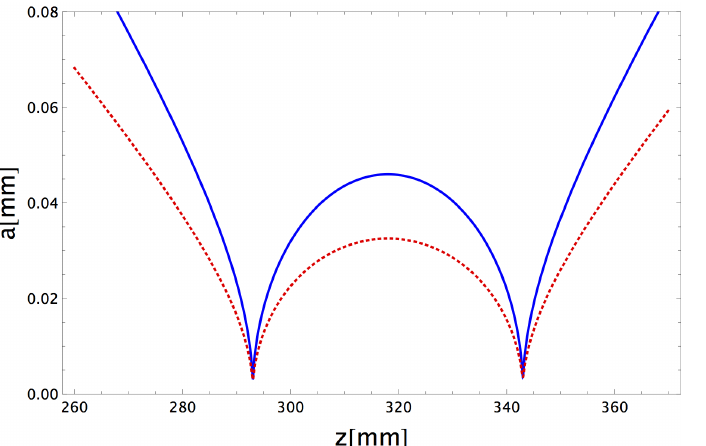
Figure 4. Behaviour of the limit object ˜ a (dashed red line) and a (cid:48) (solid blue line) as a function of the distance z between the object and the lens. The two functions have consistent behaviours, with minima close to the two reference planes z a = 293mm and z b = 343mm and a local maximum close to the midpoint z = ( z a + z b ) /2. While the two limits coincide close to the focused planes, the limit √ a (cid:48) is more restrictive by a factor of 2 in out-of-focus